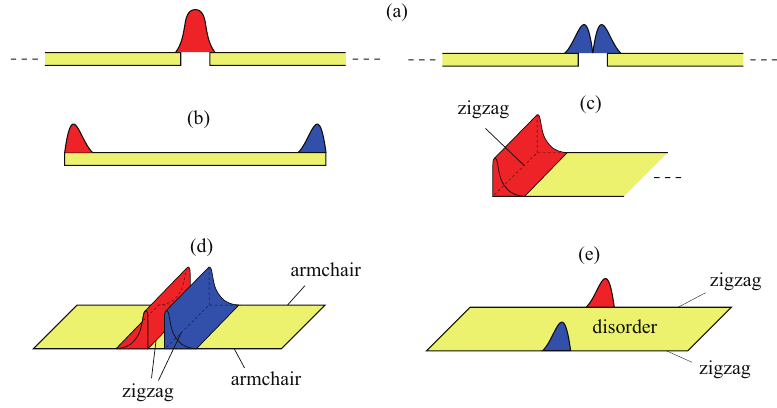
Figure 1. Possible soliton states discussed in this paper. The probability densities of a soliton on A and B carbon atoms are indicated by red and blue colors, respectively. ( a ) Chiral zero modes of polyacetylene: the domain-wall soliton (left) and antisoliton (right) have different chiralties. ( b ) End-state soliton of polyacetylene with charge fractionalization: this soliton can be represented by the bonding or antibonding linear combination of the chiral end states. ( c ) Chiral zero mode on zigzag edge of semi-infinte armchair graphene ribbon. ( d ) Domain-wall soliton of armchair graphene nanoribbon under local tensile strain. The probability densities on the A and B carbon atoms have a small overlap. ( e ) Charge fractionalization on zigzag edge of interacting disordered zigzag nanoribbon. The probability densities on the A and B carbon atoms are well